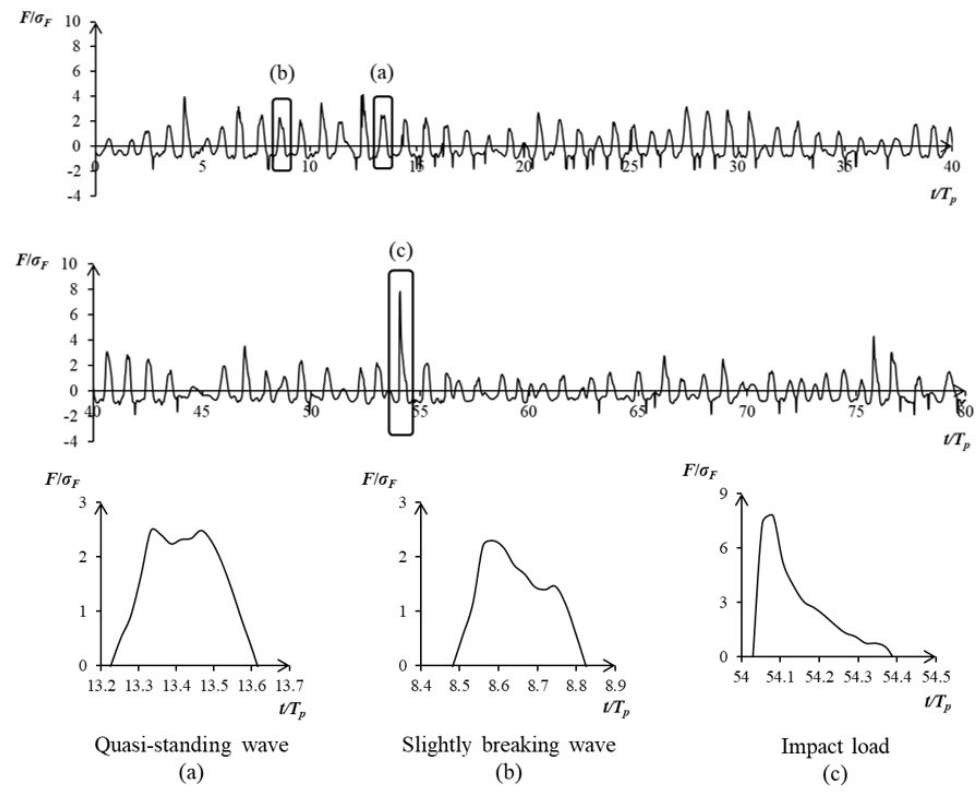
Figure 4. Example of complete time series of the wave force, with the occurrence of the three cases of wave loads: ( a ) Quasi-Standing: ( b ) Slightly Breaking; ( c ) Impact Load.